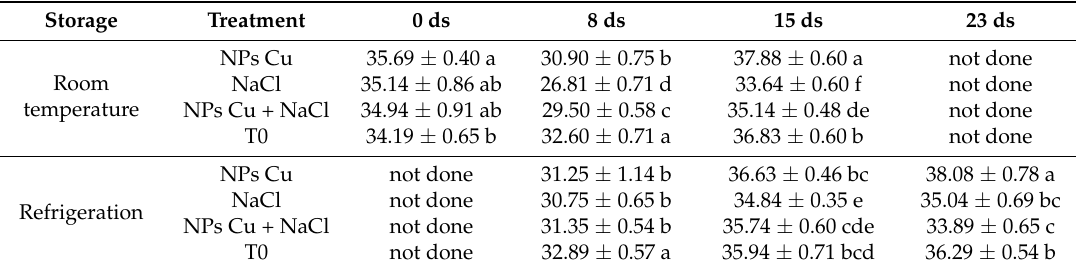
Table 1. Total phenols content (milligrams equivalent of gallic acid per 100 g dry weight) in tomato fruits at different storage times at room temperature (24 ± 1 ◦ C) and refrigeration (4 ± 1 ◦ C and relative humidity at